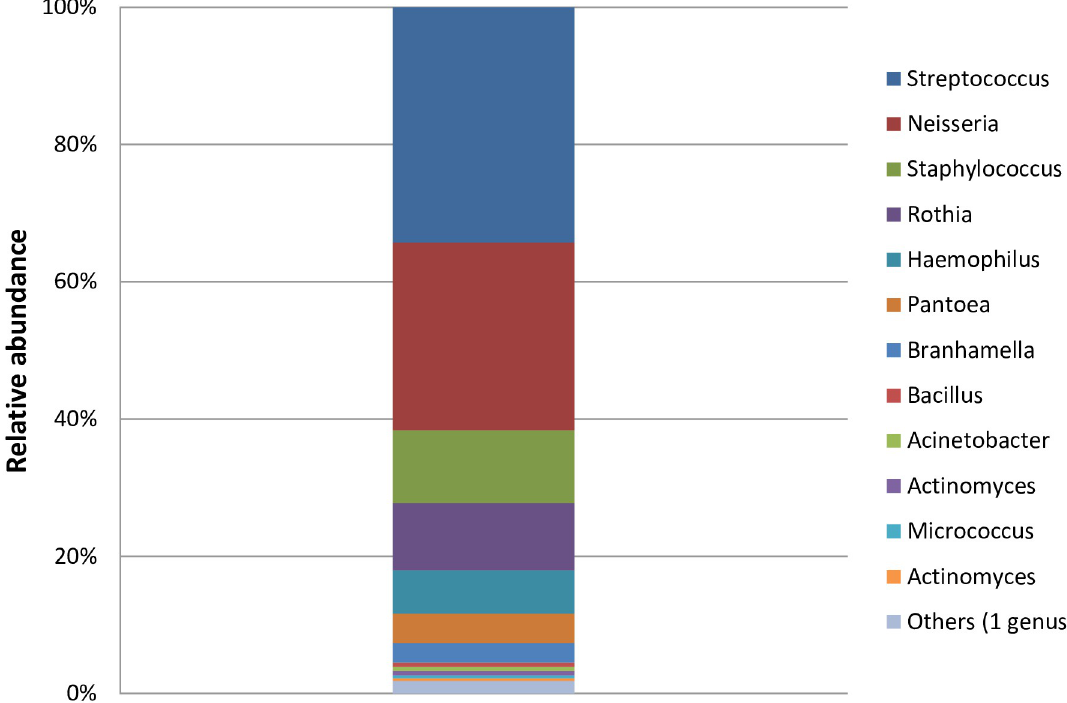
Fig 2. Number of isolates of the 12 most-abundant genera identified by culture techniques in duodenal aspirates of stunted children. The color code for the different genera is given on the right.